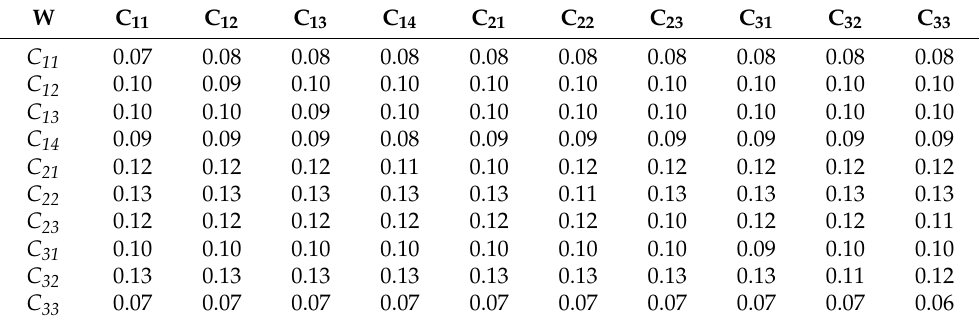
Table 6. Weighted supermatrix W .